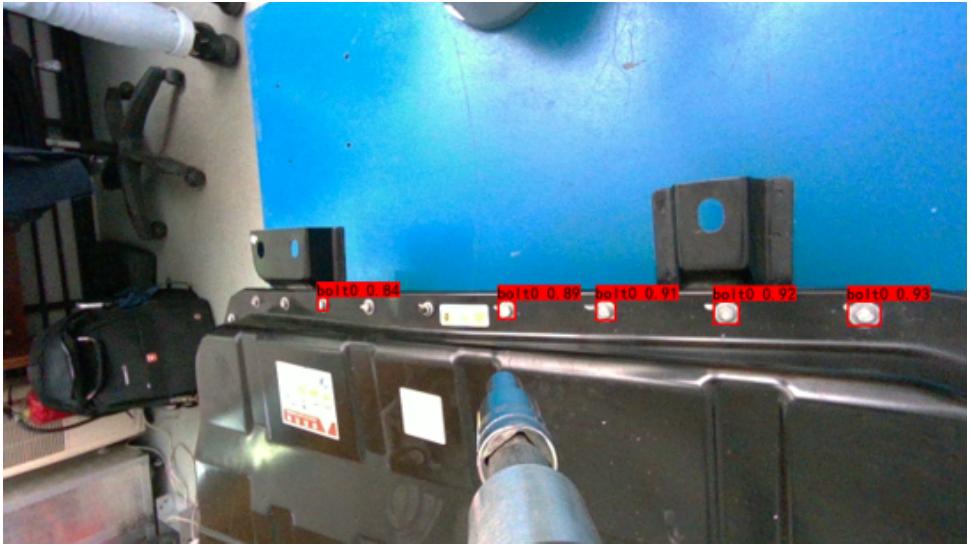
Figure 15. Results of the initial positioning of the